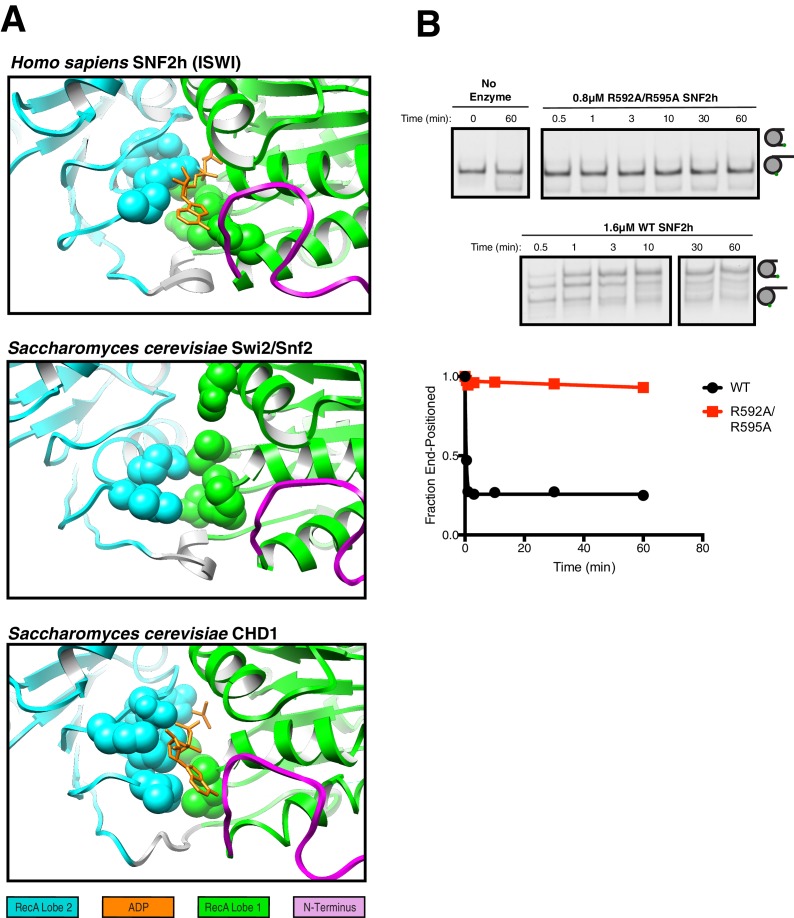
Comparison of ATP-binding pockets of SNF2h with CHD1 and Swi2/Snf2 and functional validation of SNF2h ATP-binding pocket.(A) Top. Close up view of the SNF2h ATP-binding pocket from the 3.4 Å structure with ADP fit in the canonical binding site. Middle. Close up view of the ATP-binding pocket from S. cerevisiae Swi2/Snf2 Cryo-EM structure (Liu et al., 2017). Bottom. Close up view of the ATP binding pocket from S. cerevisiae CHD1 Cryo-EM structure with ADP-BeFx fit in the canonical binding site (Sundaramoorthy et al., 2018). The conserved helicase motif I and helicase motif VI that are required for ATP hydrolysis are shown in space fill. (B) Mutation of the putative arginine fingers to alanine abolishes sliding activity. Top. Native gel remodeling assay with saturating concentrations of SNF2h. Bottom. Quantification of the gel fit to a single exponential decay.